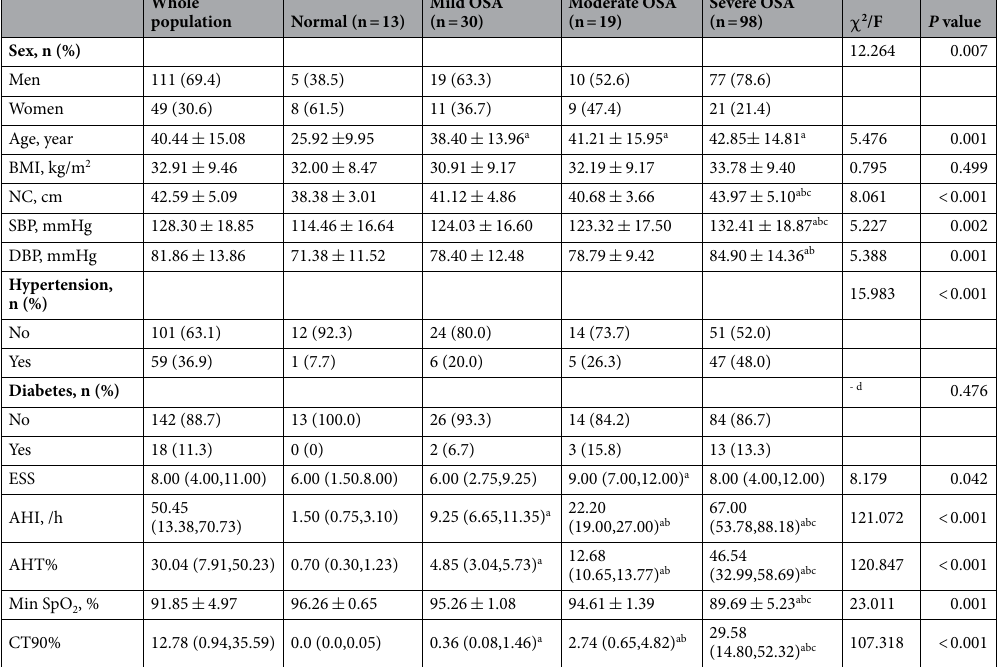
Table 1. Baseline characteristics of the sleep study cohort according to the AHI. AHI apnoea-hypopnoea index; OSA obstructive sleep apnoea; BMI body mass index; NC neck circumference; SBP systolic blood pressure; DBP diastolic blood pressure; ESS Epworth Sleepiness Scale; AHT% the percentage of total sleep time spent with apnoea and hypoponea duration time; Min SpO 2 minimum nocturnal oxygen saturation; CT90% percentage of total sleep time with an oxygen saturation of < 90%. a,b,c The differences were statistically significant compared with the normal, mild and moderate AHI groups, respectively ( P < 0.05). d Fisher’s exact probability was